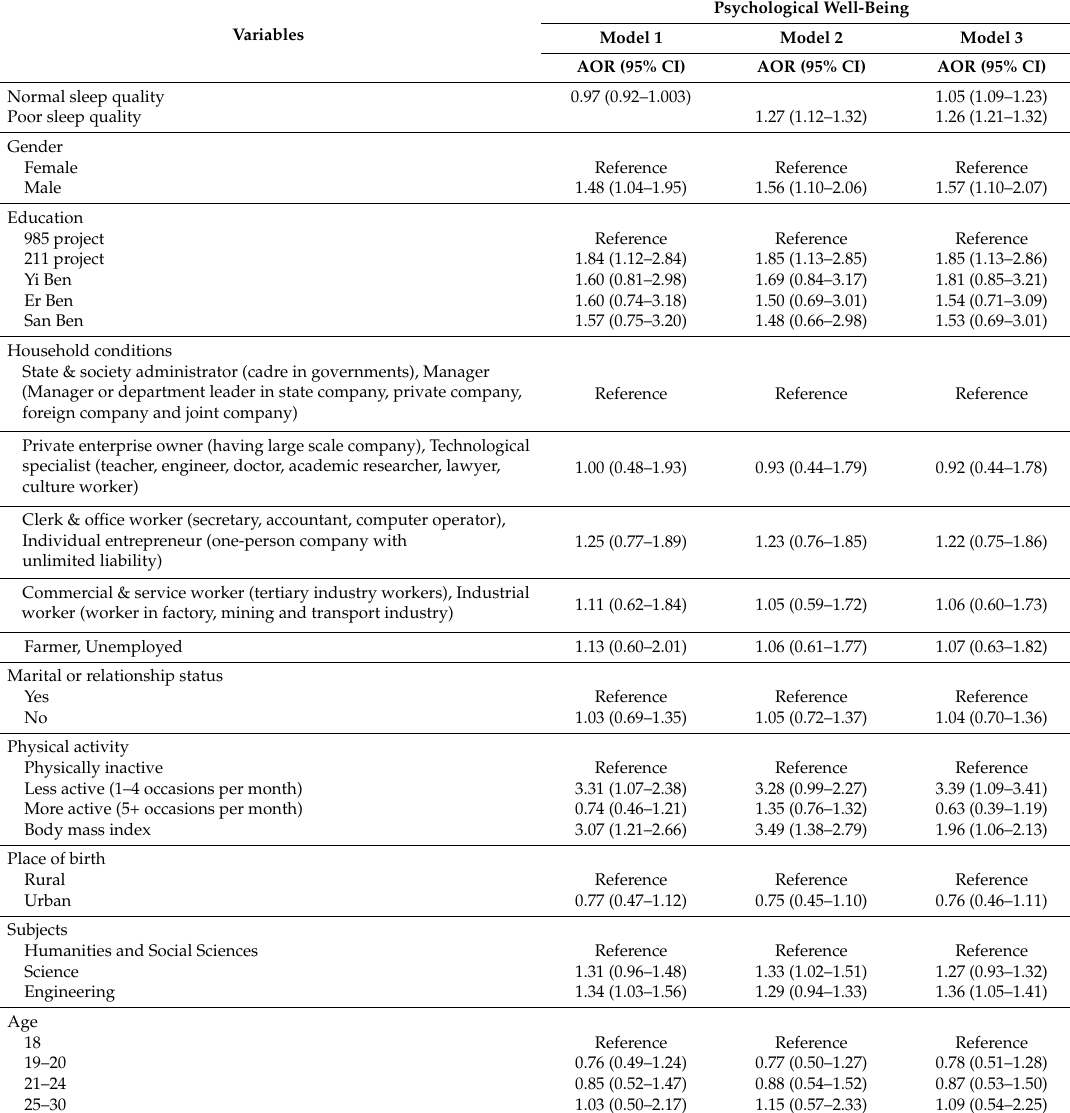
Table 3. Multivariable associations of psychological well-being as a dichotomous variable ( N = 2495).